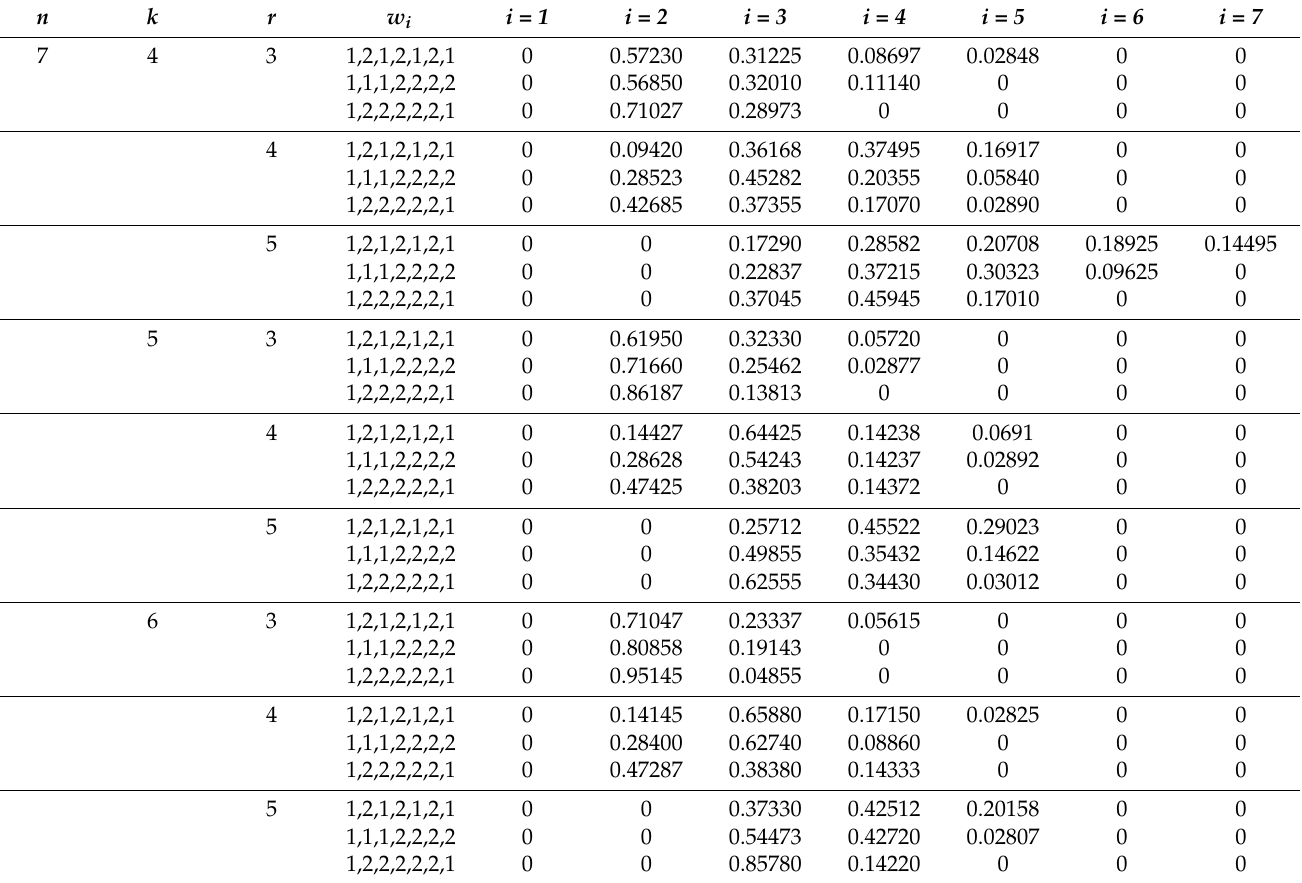
Table 3. The signature of the weighted- r -within-consecutive- k -out-of-7: F